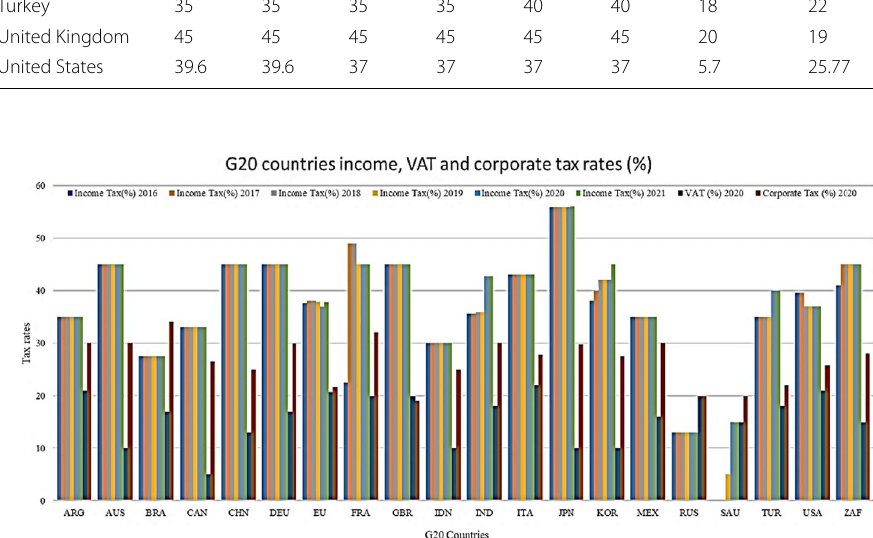
Fig. 8 G20 countries income, VAT, and corporate tax rates